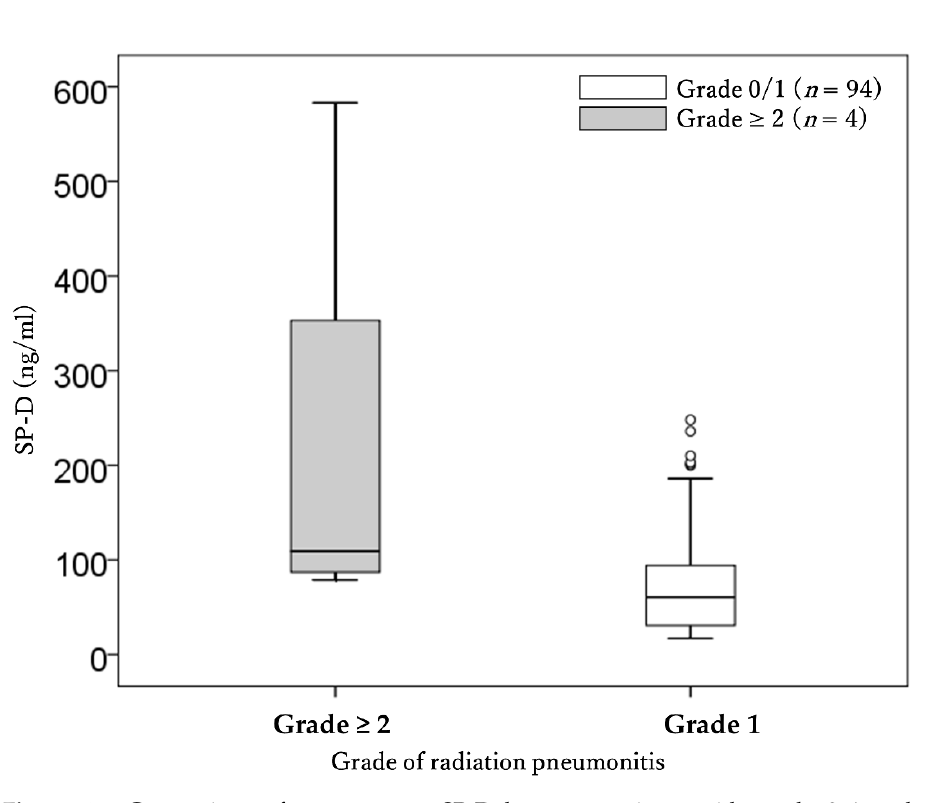
tion pneumonitis. 2–3 radiation